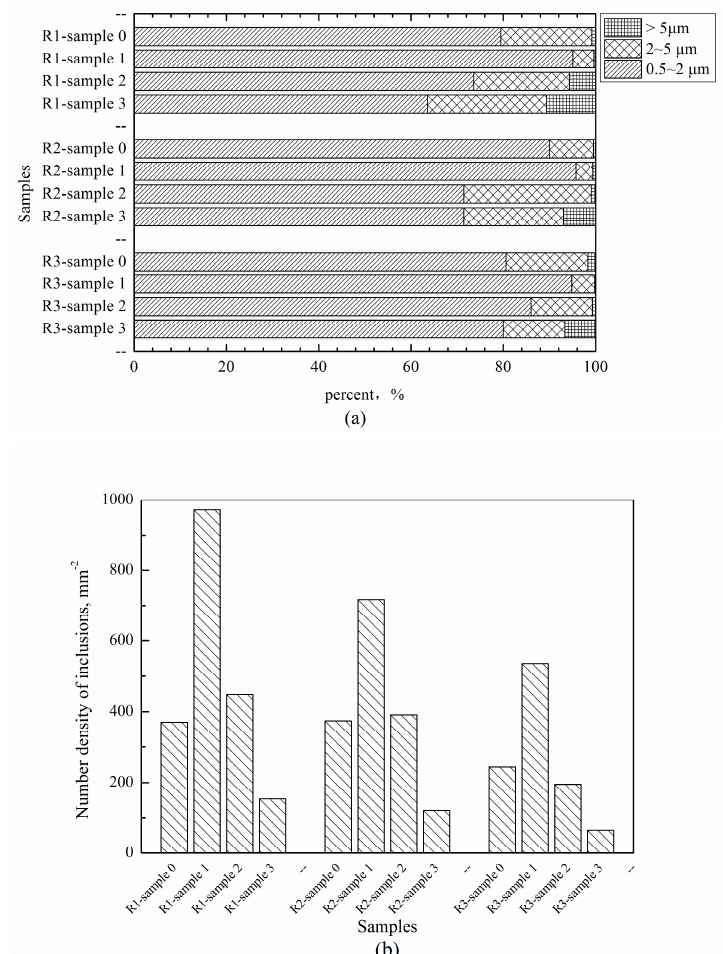
Figure 4. Size distribution ( a ) and number density ( b ) of inclusions in three steels at different stages.